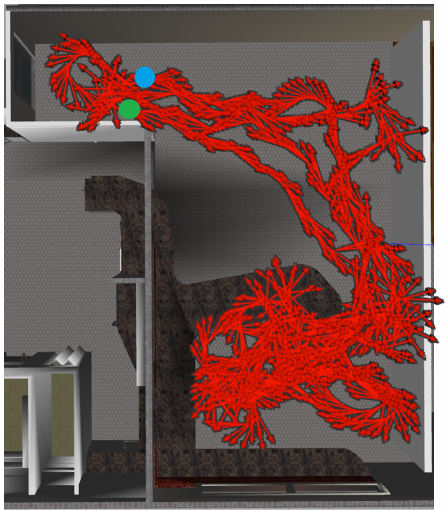
Figure 10. The results of covering in simulation. The trajectory of the robot is represented by a set of red arrows. The green point is the start point of exploration and the blue one is the end point.